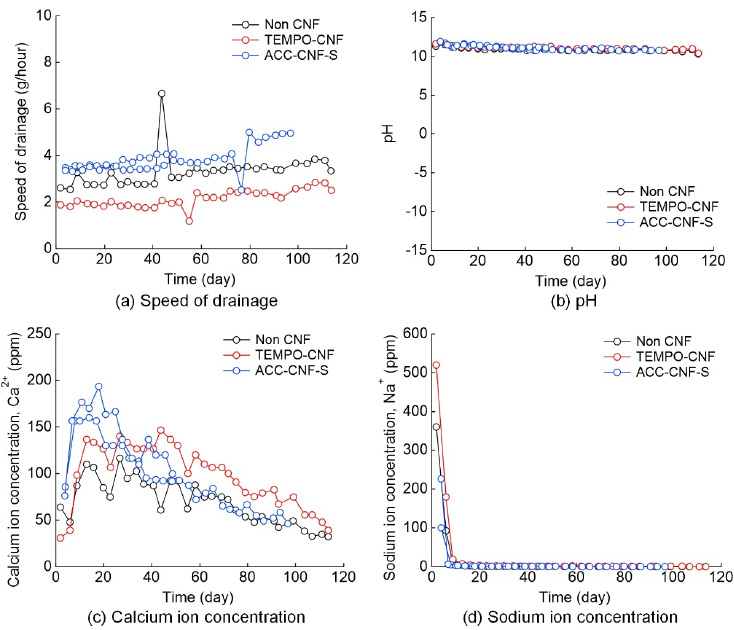
Appl. Sci. 2021 , 11 , x FOR PEER REVIEW Figure 16. Chemical properties of drained water. Figure 16. Chemical properties of drained water.